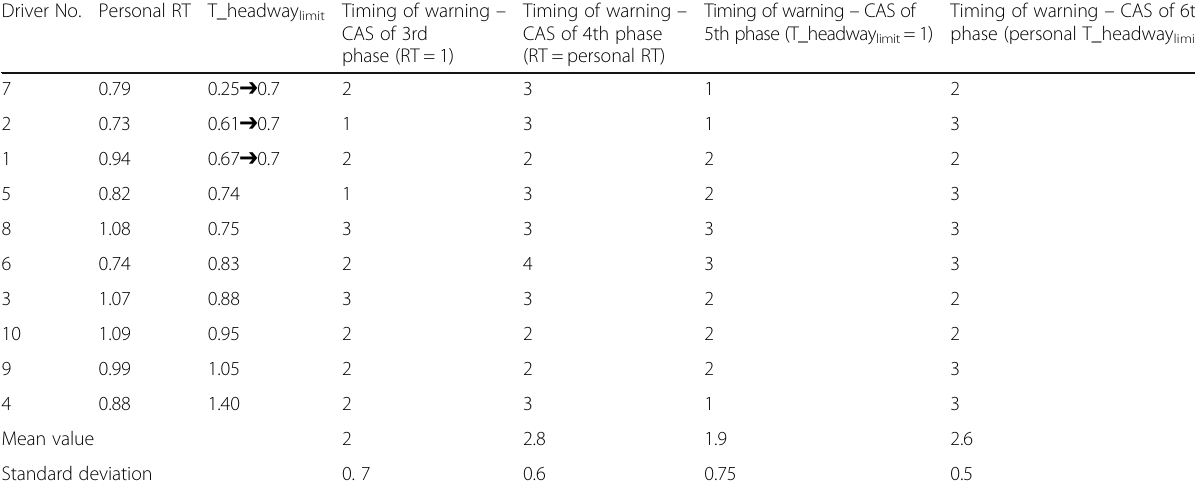
Table 4 Comparative results on the timing of the warnings given by the CAS per system/phase Driver N ο . Personal RT T_headway limit Timing of warning – CAS of 3rd